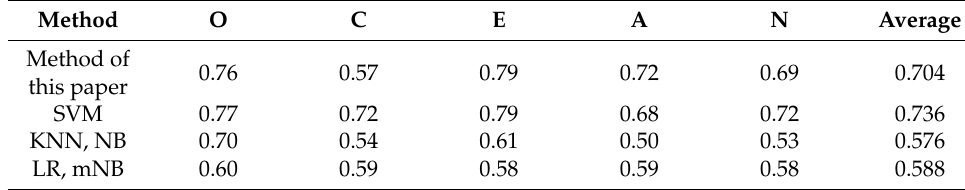
Table 8. Comparison of recall rates.